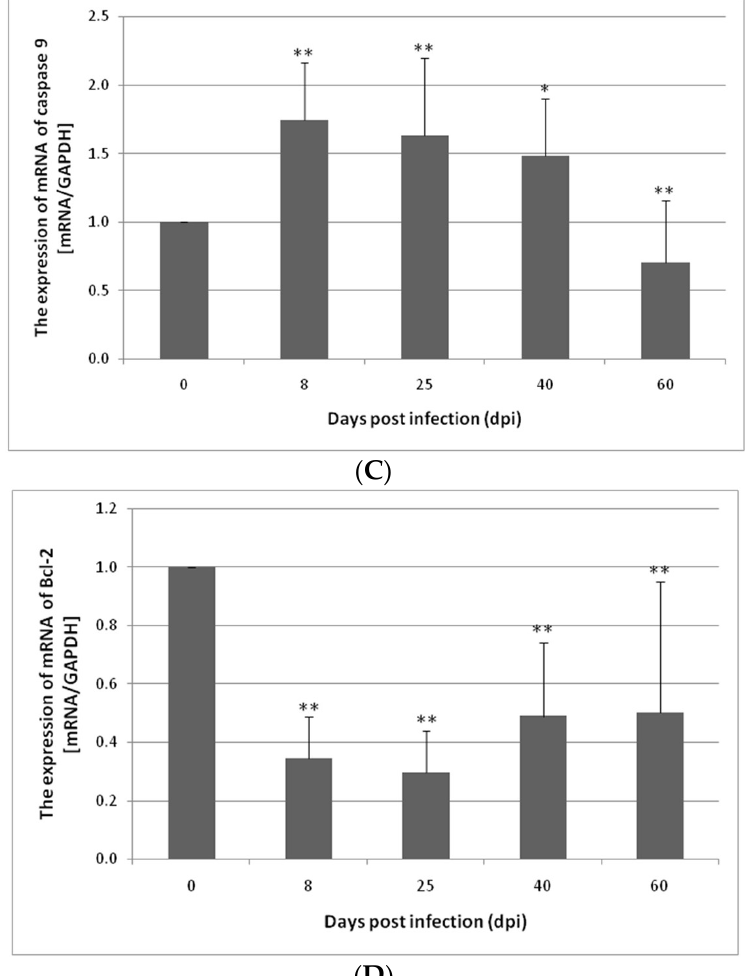
Figure 1. Expression of Bax ( A ), caspase-3 ( B ), caspase-9 ( C ), and Bcl-2 ( D ) genes at the mRNA level in the small intestine from uninfected and H. diminuta -infected rats. Data represent the arithmetic mean ± SD and are representative of individual groups of six animals in each experiment. Statistical analysis was performed using the Kruskal–Wallis test, * p < 0.05, ** p < 0.01 vs. 0 dpi.